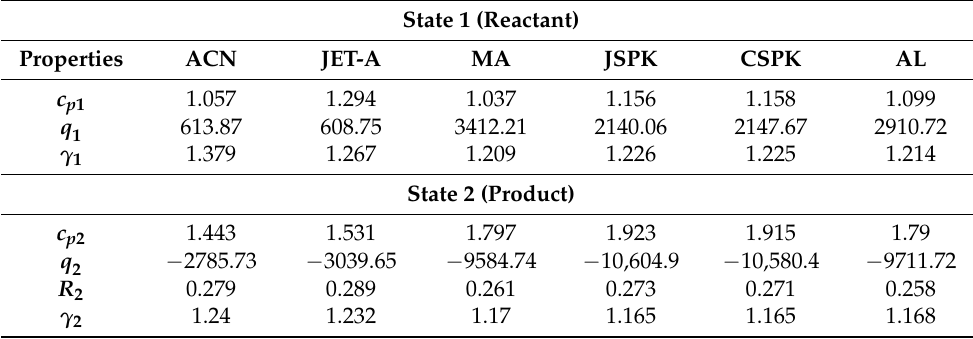
Table 4. Thermochemical properties during the